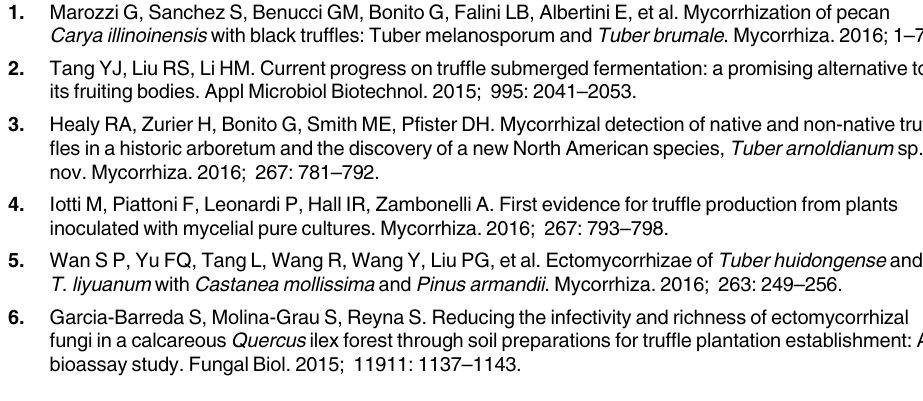
number of OTUs increased with sequencing reads. ECM and ECM.S, ectomycorrhizae ( Pinus armandii mycorrhized with Tuber indicum ) and ectomycorrhizosphere soil. CK and CK.S, roots and soils from cultivated P . armandii without T . indicum partner. S2 Fig. Numbers of shared and specific bacterial (a) and fungal (b) Operational Taxonomic Units (OTUs). ECM and ECM.S, ectomycorrhizae ( Pinus armandii in association with Tuber indicum ) and ectomycorrhizosphere soil. CK and CK.S, roots and soils from cultivated P . armandii without T . indicum partner. S1 Table. Spearman correlation coefficient (rs) between soil properties and indicators of bacterial community structure. S2 Table. Spearman correlation coefficient (rs) between soil properties and indicators of fungal community